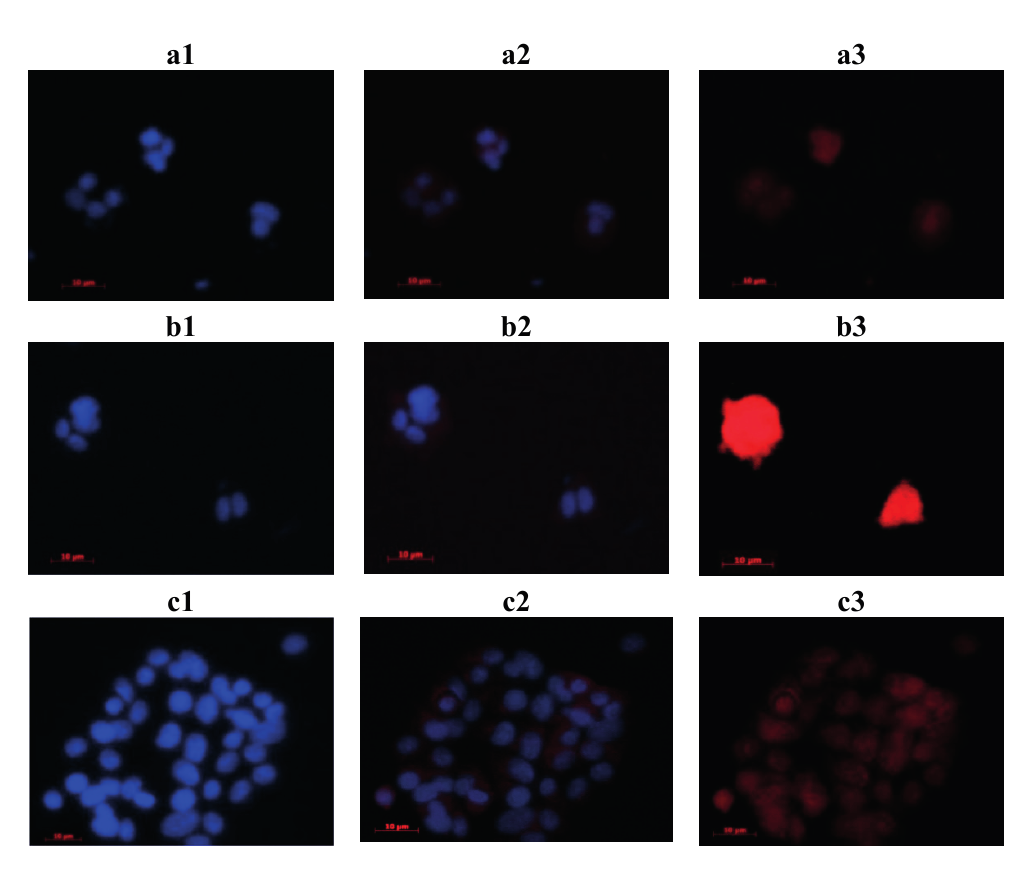
Figure 7. Fluorescence images of the interaction between phthalocyanines (45.0 µM final concentration) 10 (images a1 – a3 ), 11 (images b1 – b3 ) and 12 (images c1 – c3 ) and MCF7 cells (grown on chamber slides at a density of 4 × 10 4 cells/cm 2 and treated with 300 nM DAPI solution). The images were produced by 365 nm excitation, using 420 nm (DAPI) and 590 nm (phthalocyanines) emission filter. DAPI was used to following the studied phthalocyanine (red fluorescence) according to the nuclei position. AXIO—observer A1